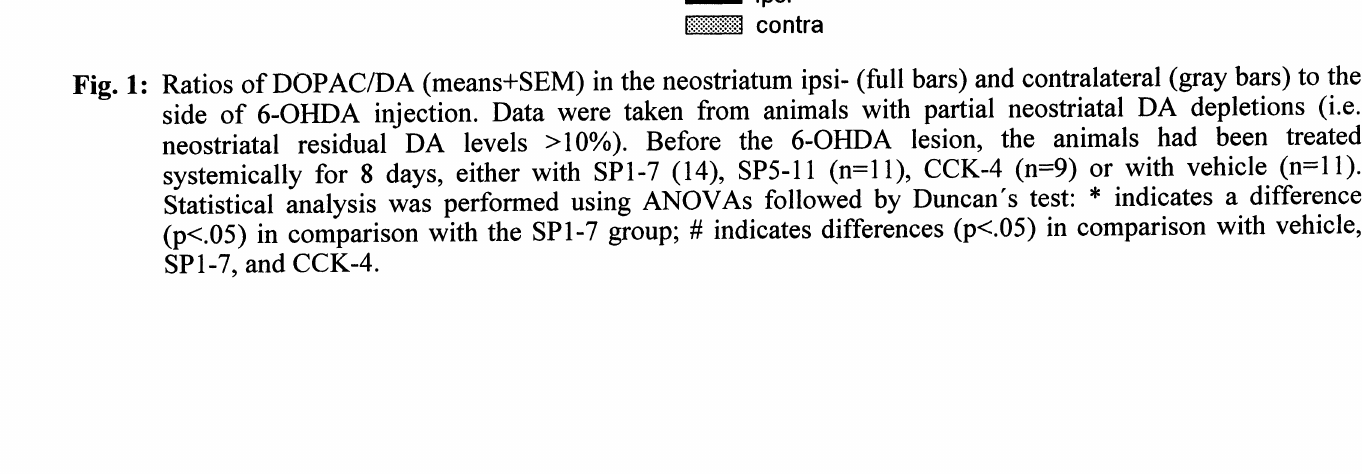
bars) to the DA depletions (i.e.